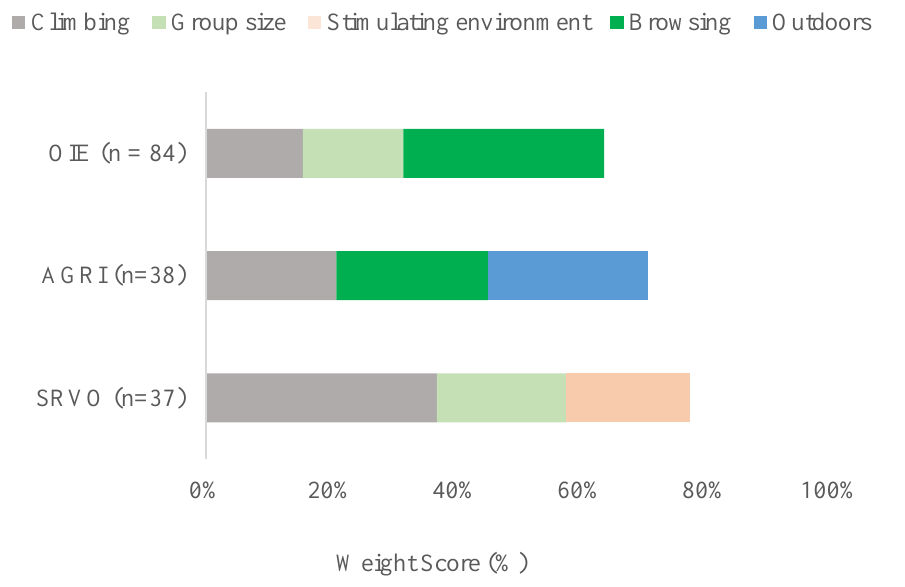
Figure 3. Ranked importance of opportunities for natural behavior expression in goats for the